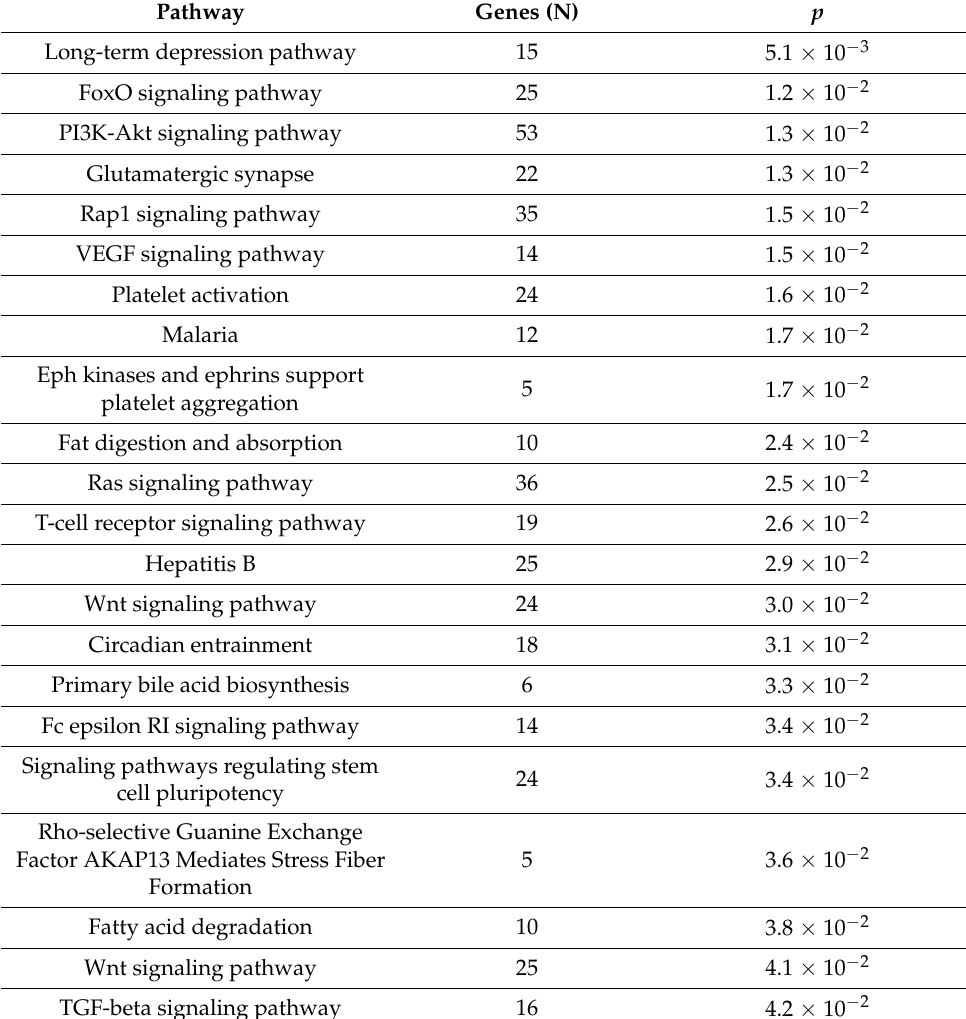
Table 3 details the list of resulting pathways after the analysis (with DAVID soft- ware) of all the genes that showed a p < 0.05 in the SKAT analysis at the gene level ( N = 2464 genes). We obtained 22 pathways ( p < 0.05) where there was an overexpression of the genes included in the analysis. Those of greatest interest were long-term depression (15 overexpressed genes of those included in the analysis), FoxO signaling pathway (25 overexpressed genes of those included in the analysis) and especially the phosphatidyli- nositol 3-kinase (PI3K-Akt) signaling pathway (53 overexpressed genes of those included in the analysis) (Figures 1–3). Table 3. Pathways with nominal significance after the analysis with DAVID software. Pathway Genes